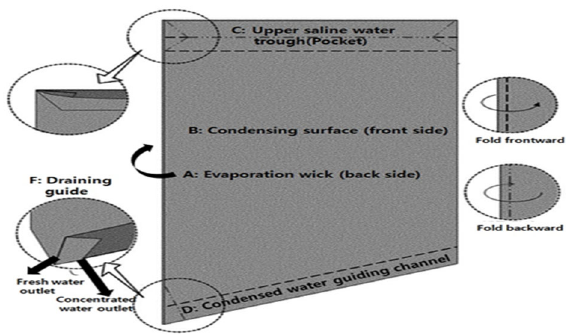
Figure 2. MSS installation site in KISR premises.